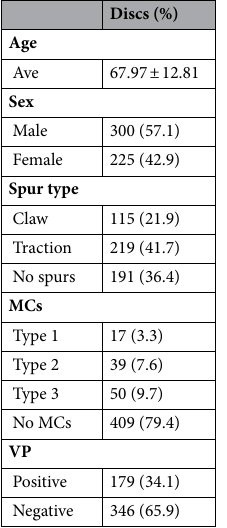
Table 1. Demographic data. MCs, Modic changes; VP, vacuum phenomenon.